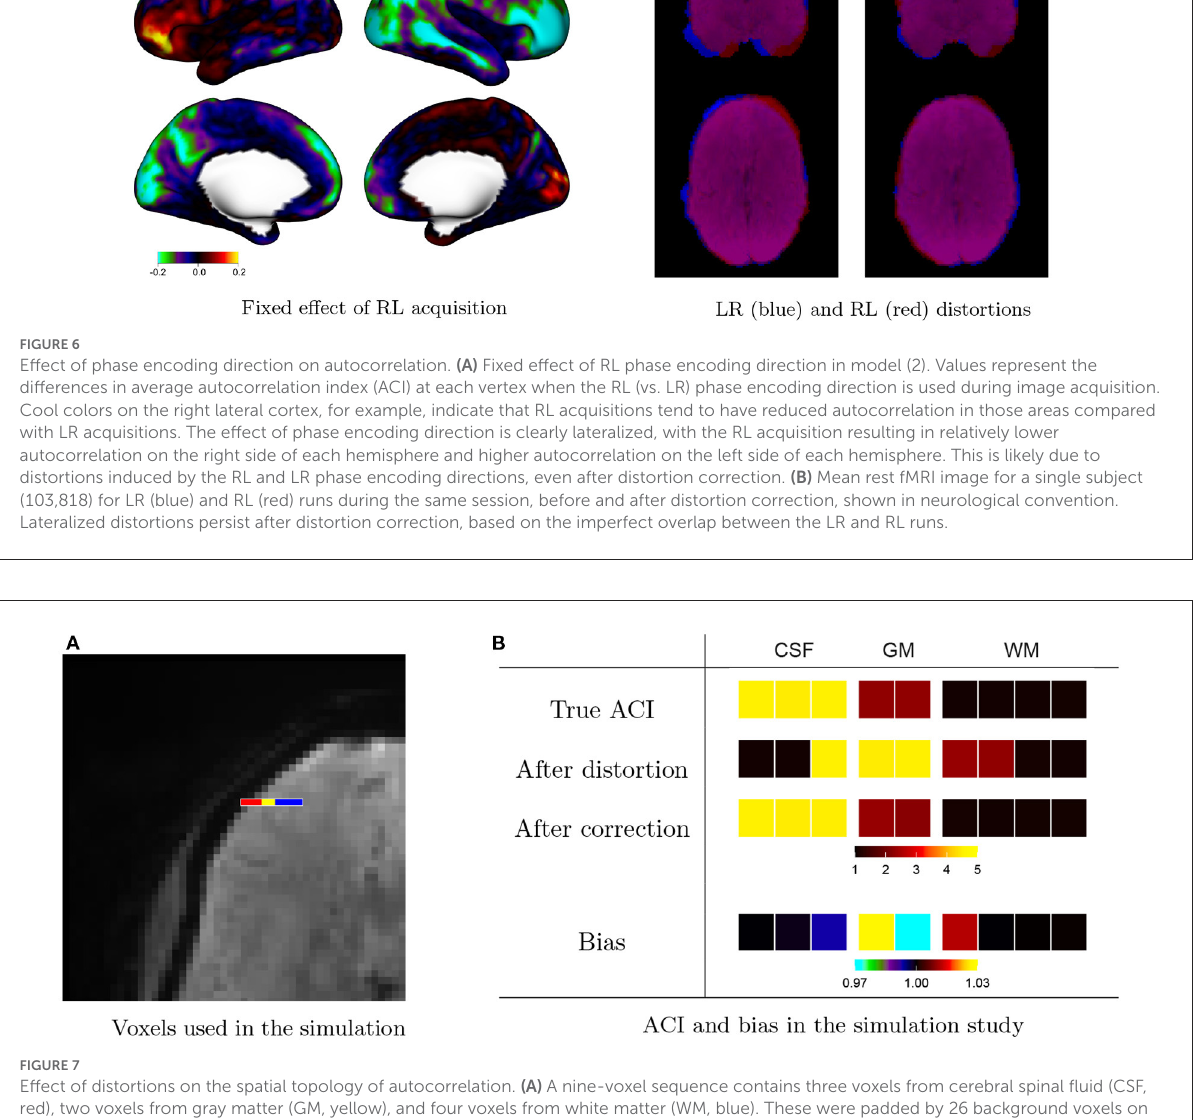
using a 5 mm full width at half maximum (FWHM) Gaussian kernel (Pham et al., 2022); “global” regularization is achieved by averaging the estimates across all cortical vertices. For optimal model order selection, all remaining coefficients after the AIC- based model order p ∗ (up to the maximum of 10) are set